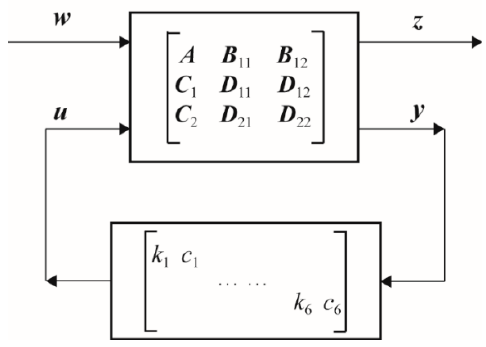
Figure 2. Block diagram of the bridge—2DOFs TMDs system with decentralized control.